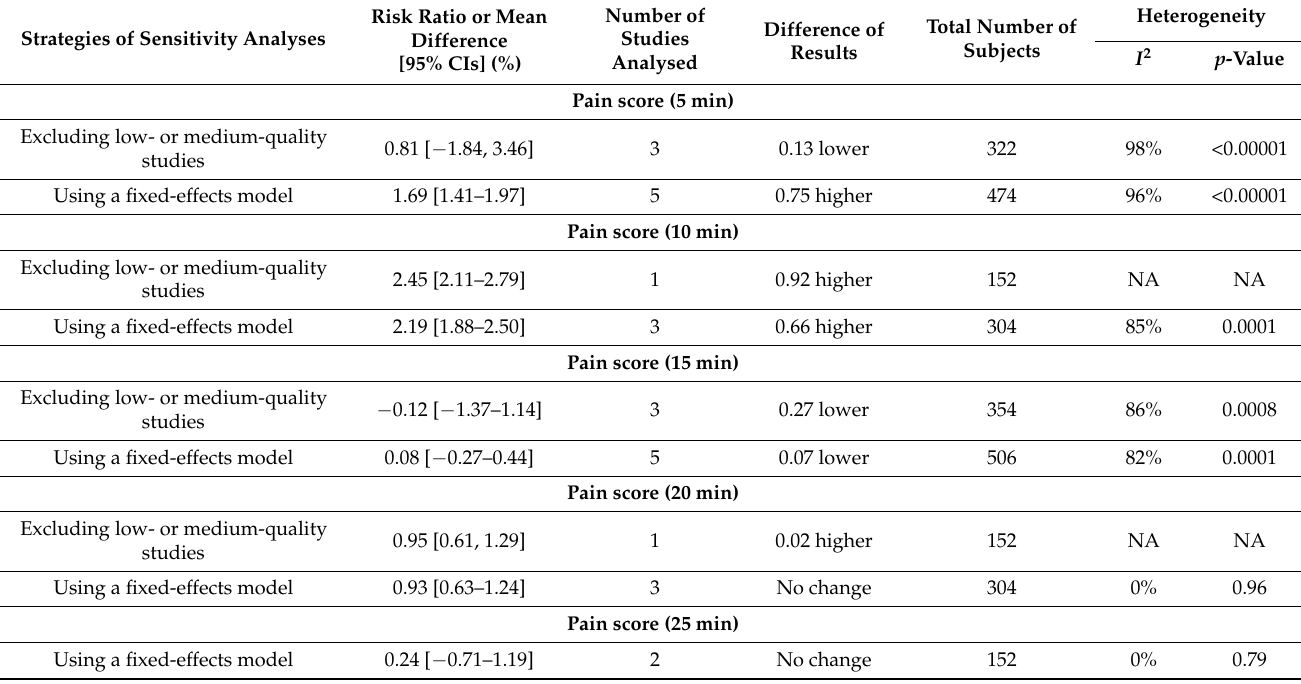
Table 3. Sensitivity